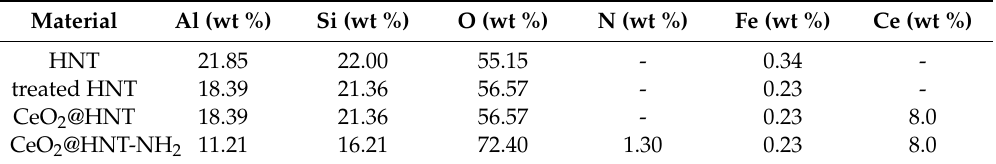
Table 1. Chemical composition of the pristine HNTs, acid-treated HNTs, CeO 2 @HNTs and